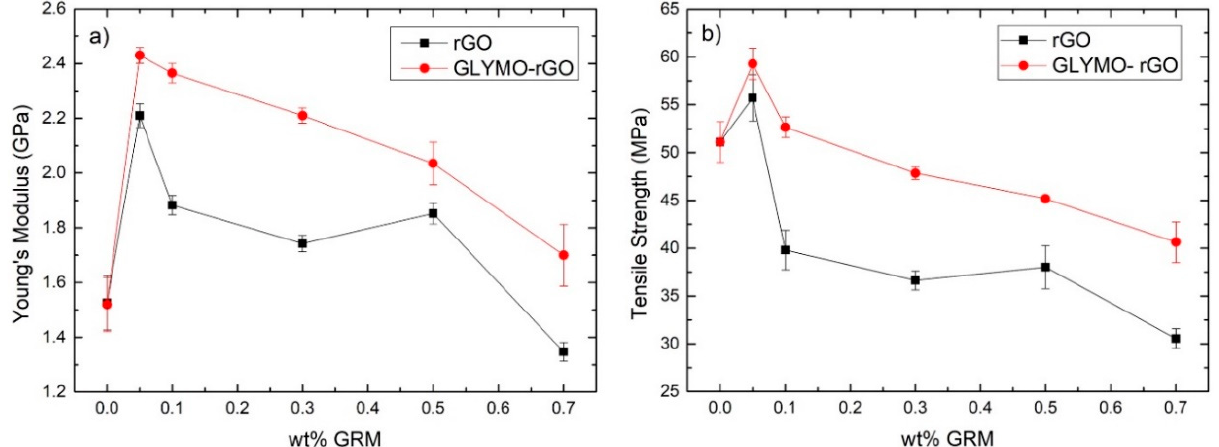
Figure 11. Mechanical properties of cured nanocomposites reinforced with different amounts of GRMs; ( a ) Young’s modulus; ( b ) ultimate tensile strength.